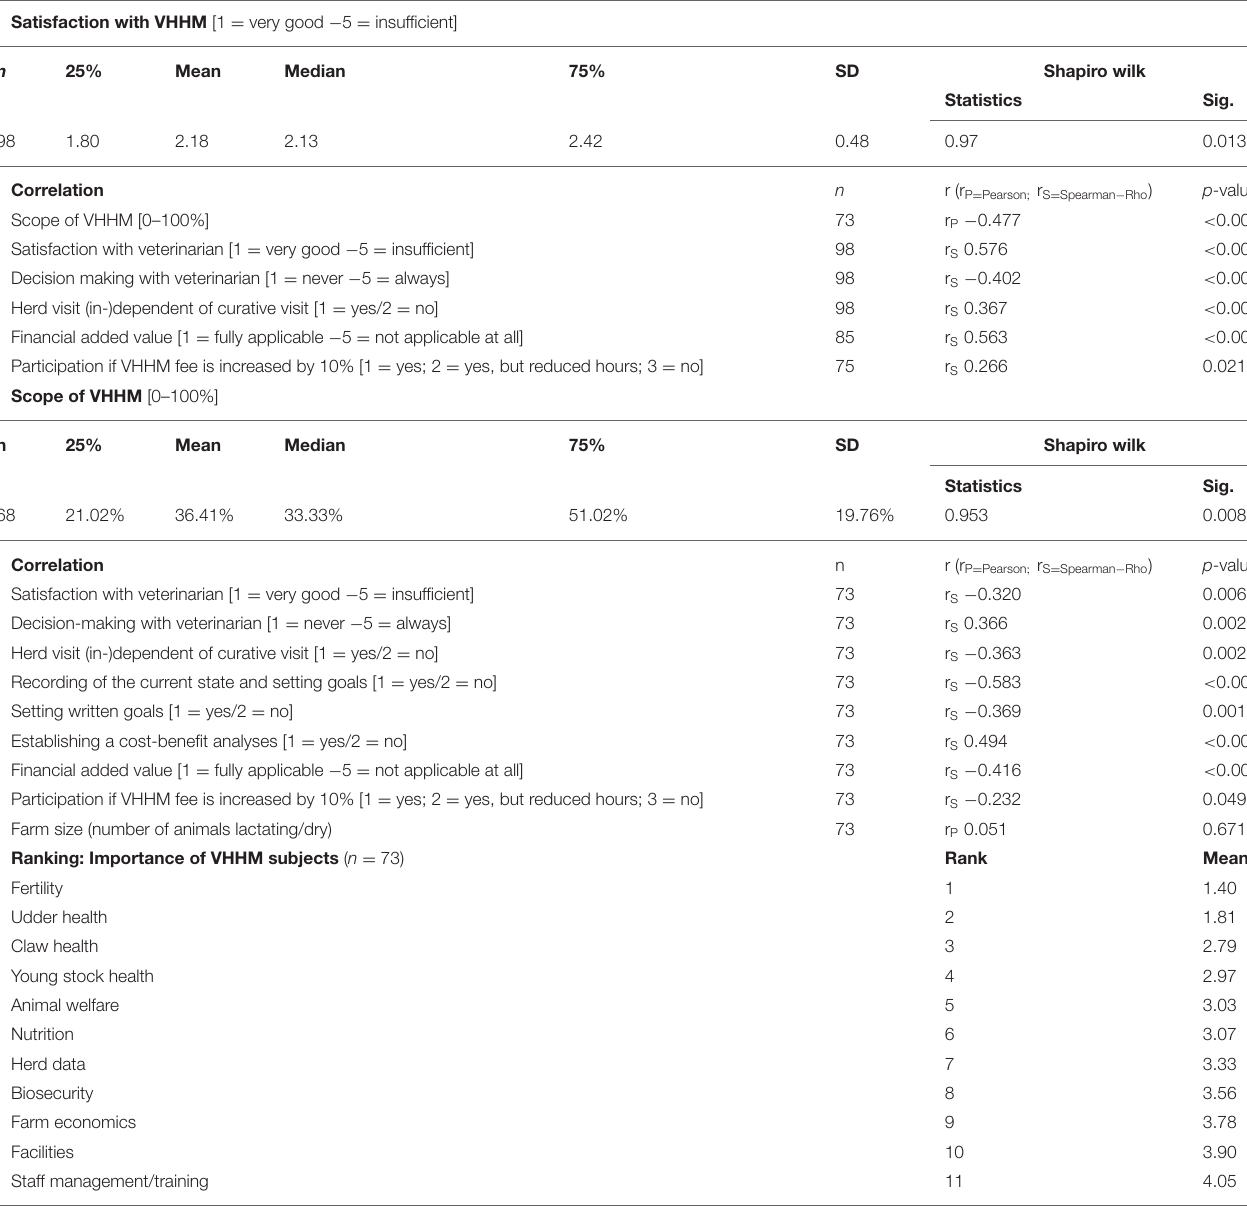
TABLE 7 | VHHM: Satisfaction with VHHM/scope of VHHM and importance of VHHM subjects. Satisfaction with VHHM [1 = very good − 5 =